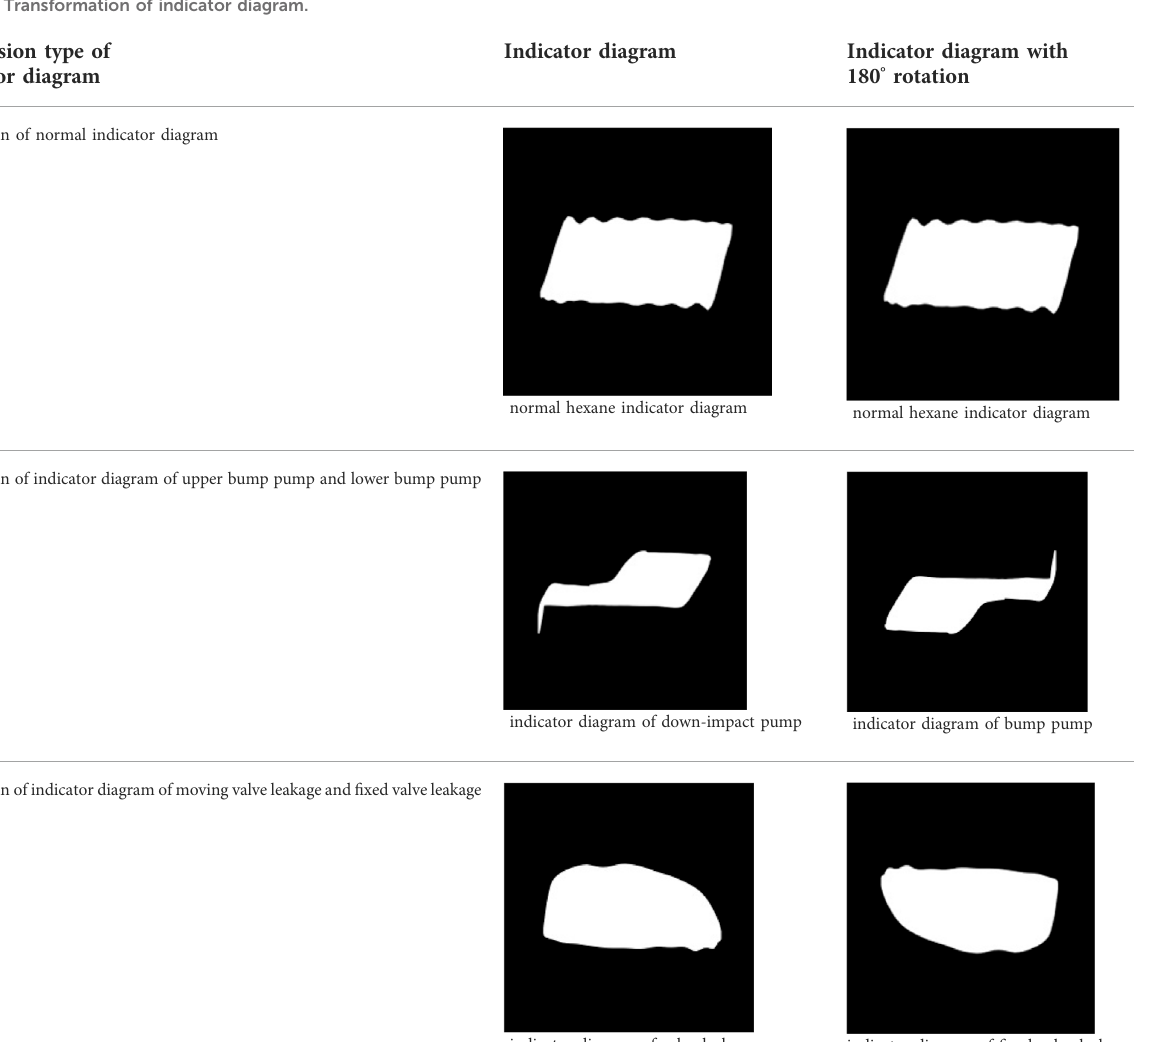
TABLE 4 Transformation of indicator